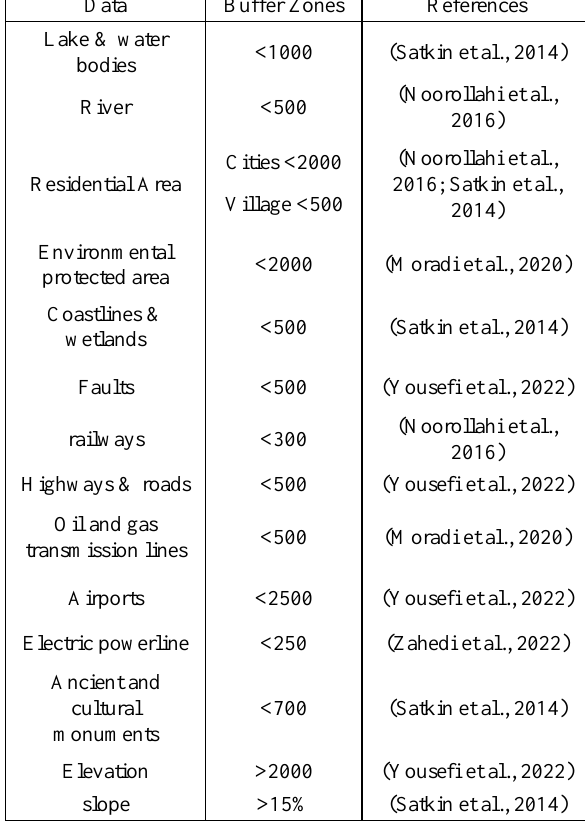
Table 3 . Exclusion parameters.